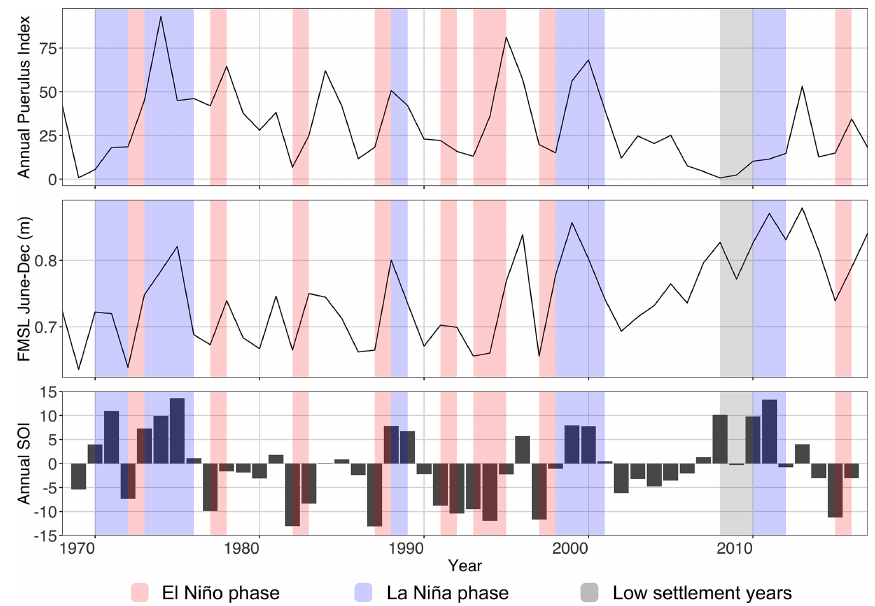
Figure 3. Time series of annual (a) fishery-wide PI (May–April), (b) Fremantle mean sea level (FMSL) over June to December (m), and (c) Southern Oscillation Index (SOI) (May–April). Grey shaded seasons indicate the less-than-expected PI based on a priori relationships (Caputi et al., 2001). Blue and red shading indicate a La Niña and El Niño periods, respectively. Updated to 2018 and modified from Fig. 5 in Caputi et al.